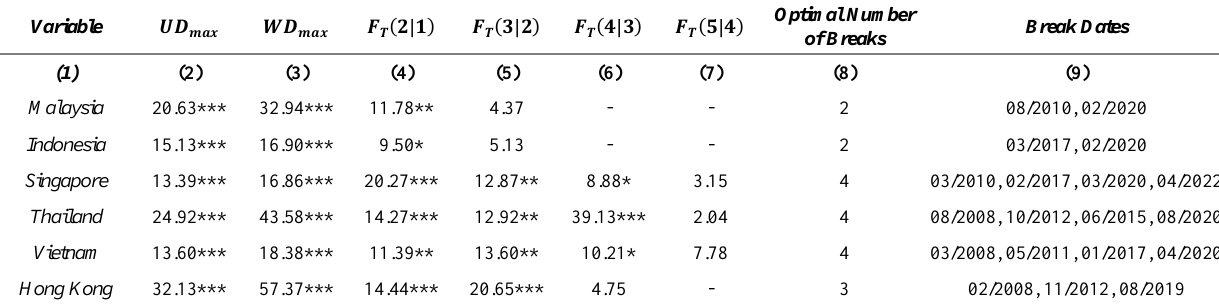
Table 1. Bai & Perron (2003) Test for Multiple Structural Breaks